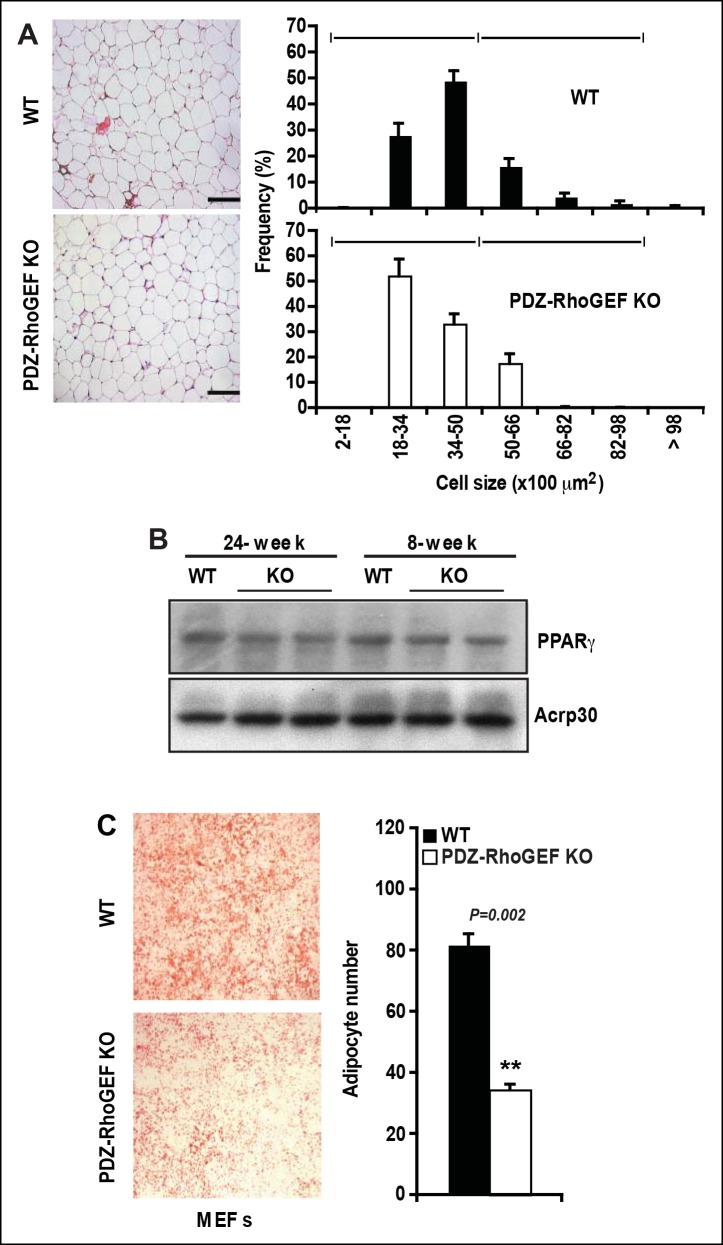
Cell size, adipogenic potential, and in vitro adipogenesis.(A) Morphometric analysis of epididymal adipocyte cell size of WT and PDZ-RhoGEF KO mice (n = 5–7). Scale bar = 100 μm (100X). (B) The protein levels of PPARγ and adiponectin (Acrp30) in EWAT from 24- and 8-week old WT and PDZ-RhoGEF KO mice. Statistical significance was calculated by a Student’s t test using Excel software (*p<0.05, **p<0.01, ***p<0.001). (C) In vitro adipogenesis of MEFs (E14.5) from WT and PDZ-RhoGEF KO assessed by Oil Red-O staining (n = 3). Statistical significance was calculated by a Student’s t test using Excel software (*p<0.05, **p<0.01, ***p<0.001).